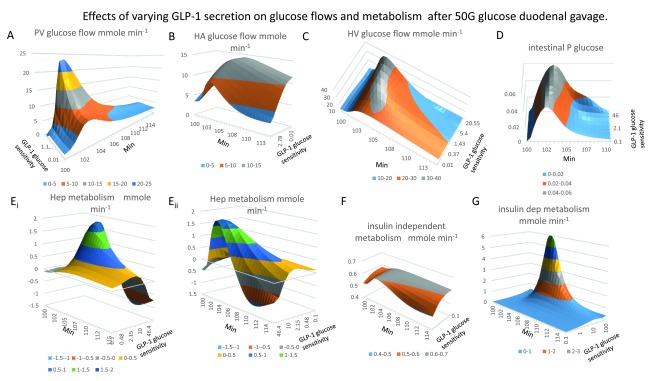
Effects of varying glucose sensitivity of GLP-1secretion on glucose flows and metabolism following 50 G glucose duodenal gavage at 100min.
Panel A The rise and fall of PV glucose flow following gavage, (
peak flow rate 18 mmole min
-1 at 2–5 min after gavage, K
½GLP-1 sens. = 12).
Panel B, HA glucose flow does not fully reciprocate PV glucose flow since raised GLP-1only reduces HA glucose to a small extent (
14.3 to 7–8 mmole min
-1 between 4–6 min after gavage).

Panel C, HV glucose flow is the sum of PV and HA flows shown in (
Panels A and
B).
Panel D The rise off unidirectional intestinal glucose permeability following gavage. Intestinal glucose permeability varies transiently with the transluminal glucose concentration gradient. This rises with the increase in luminal glucose concentration and falls from the peak when glucose gavage ceases and luminal glucose concentration falls and splanchnic capillary glucose concentration rises due to glucose absorption (see
Figure 4
Panel G) Raising GLP-1glucose sensitivity increases the peak glucose permeability by 20%. GLP-1increases peak flow glucose permeability from the baseline at the start of gavage compared with maximal glucose gradients by five-fold.
Panels Ei,
Eii Mirror views of the effects of GLP-1on hepatic glucose metabolism following gavage. Negative values signify negative net glucose uptake NHGU i.e. positive glucose outflow resulting from glucagon stimulation and suppression of GLP-1and insulin signalling to liver. High GLP-11 sensitivities increase NHGU during times of peak PV glucose flow, however later times, high GLP-1sensitivities leads indirectly to very high rates of glucagon-dependent gluconeogenesis
K
½GLP-1 sens. = 18.
Panel F Peripheral glucose metabolism increases only slightly with raised systemic glucose concentration following glucose absorption and falls when high rates of glucose sensitive GLP-1secretion drive metabolism to induce hypoglycaemia.
Panel G Insulin-dependent glucose metabolism is extremely sensitive to glucose sensitive GLP-1secretion. The maximal rate is > 100-fold higher than fasting rates. With low GLP-1 net hepatic glucose output is reduced and hepatic uptake reduced during the absorption phase 100–145 min. Low GLP-11 secretion reduces peripheral insulin sensitive glucose uptake.